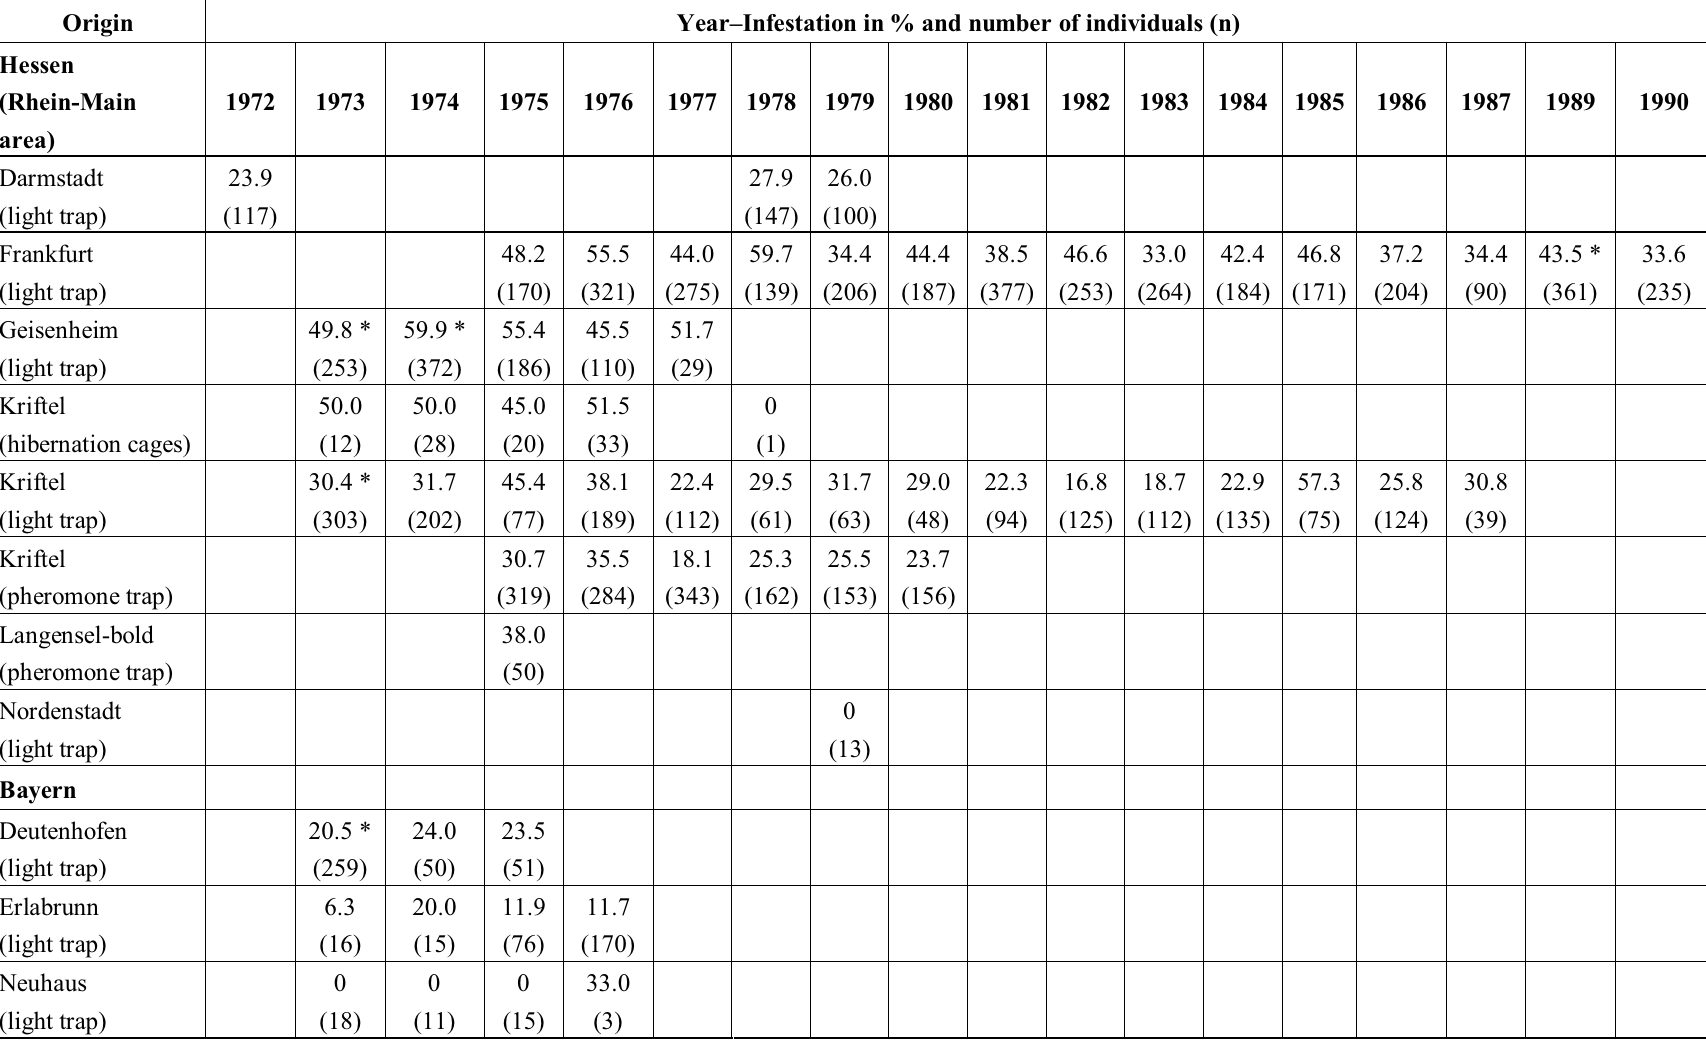
Table 5. Occurrence and prevalence of the microsporidium, Nosema carpocapsae , in adults of C. pomonella , from various regions in Germany (Hessen, Bayern and Baden-Württemberg) captured by light traps and pheromone traps, as well as from hibernation cages (1972 (cid:177) 1990